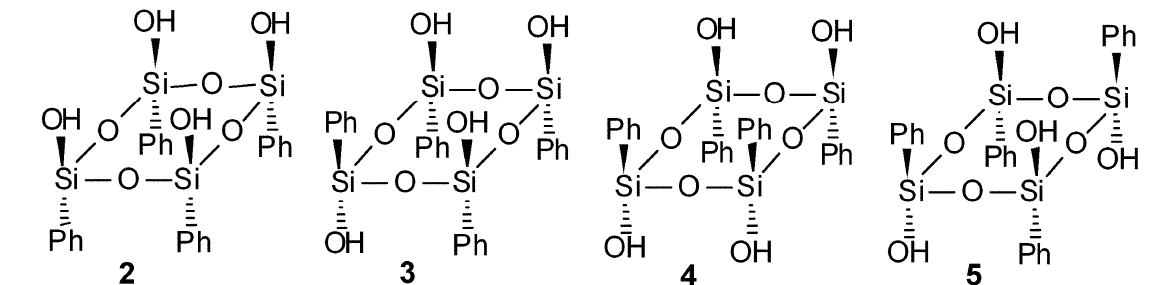
Figure 1. The geometric isomers of (tetrahydroxy)(tetraphenyl)cyclotetrasiloxane.